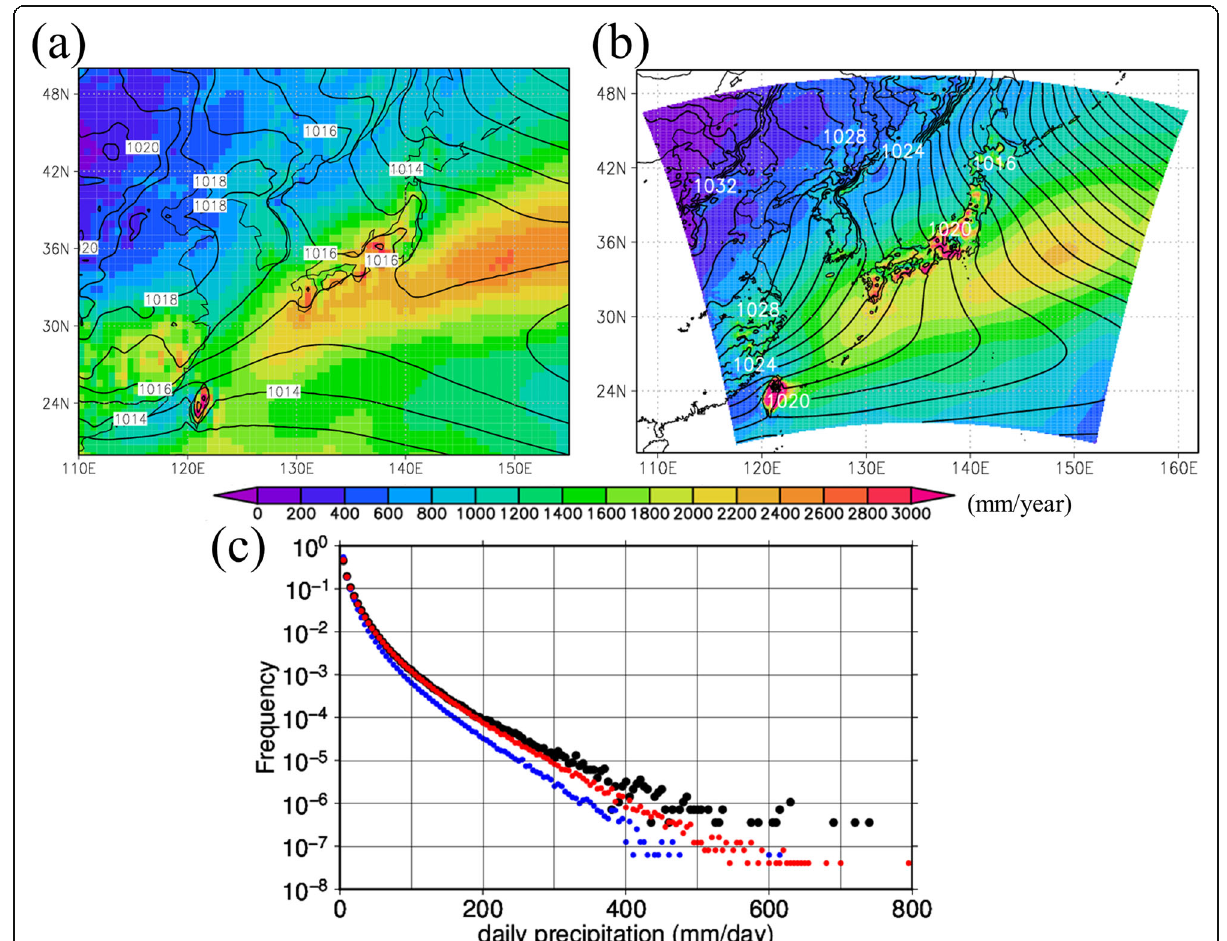
Fig. 2 Annual accumulated precipitation, SLPs, and frequencies of daily precipitation. a and b show annual precipitation (mm, shaded) and annual mean SLP (hPa, contours) by a the MRI-AGCM and b the NHRCM20. c shows the frequencies of daily precipitation for all grids on the Japanese Islands (black, AMeDAS observations; blue, AGCM; and red,